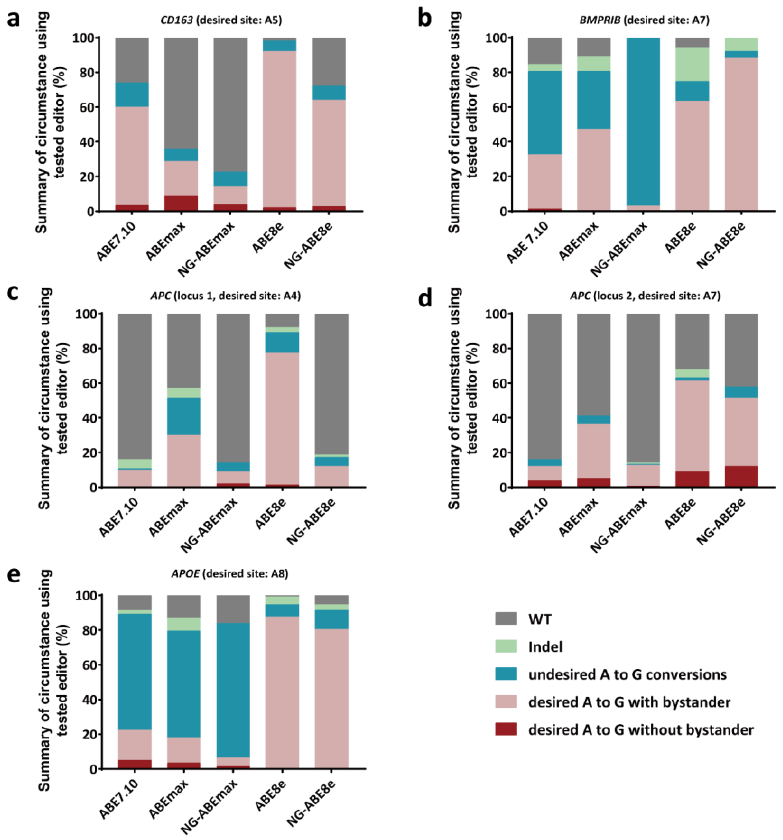
Figure 3. Frequencies of alleles carrying different types of mutations at the CD163 ( a ), BMPRIB ( b ), APC (locus 1) ( c ), APC (locus 2) ( d ) and APOE ( e ) gene loci with puromycin selection and using multiple ABEs. n = 3, independent